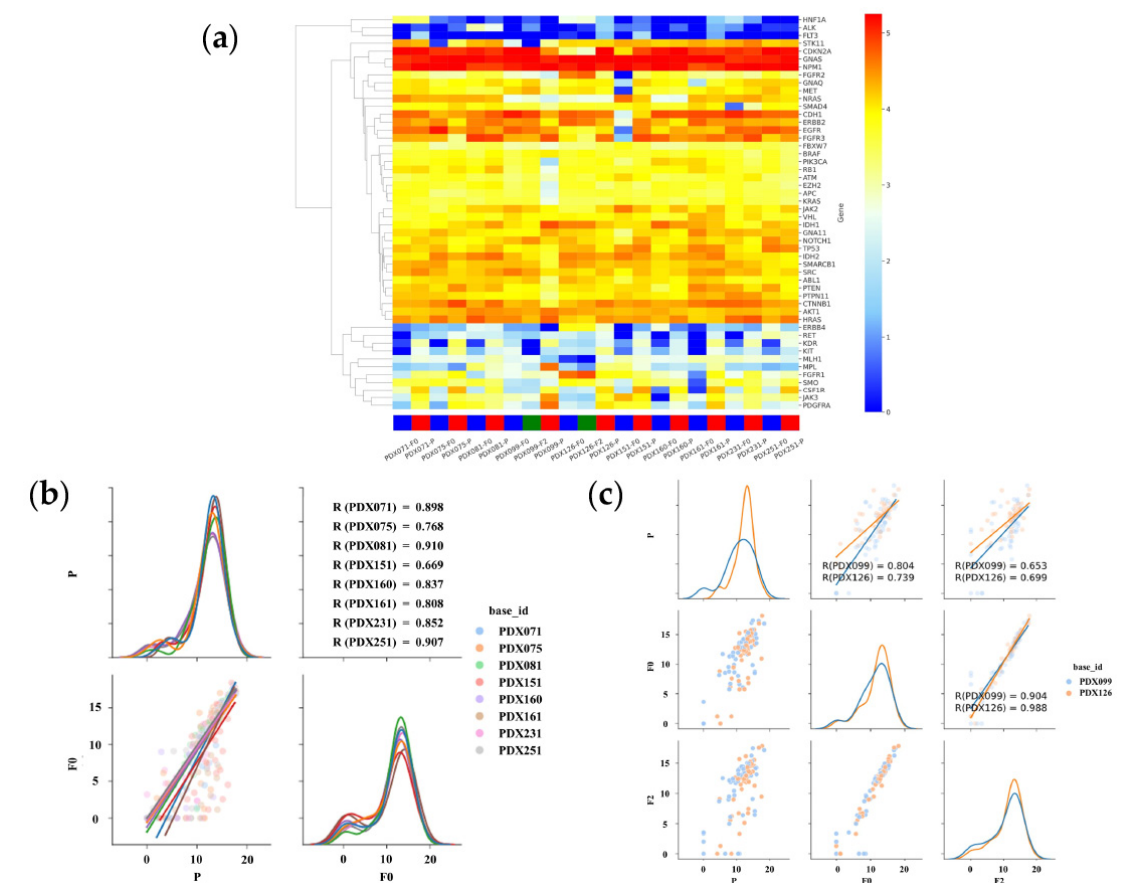
Figure 5. Summary of the relationship between gene expression in primary and PDX tumors based on RNA sequencing (RNA-seq). ( a ) The clustering and heatmap analysis of the mRNA profiling in tissues of the PDX and primary tumors using the AmpliSeq RNA Cancer Panel. In all cases, gene expression in primary (P) and PDX (F0 and F2) tumors are highly correlated. ( b ) Pair plot showing gene expression using the AmpliSeq RNA Cancer Panel in eight PDX (71, 75, 81,151, 160, 161, 231, and 251) models. The lower-left graph shows a scatter plot and linear regression of gene expressions in the P and F0 tumors. The diagonal graph shows the KDE. In all cases, gene expression in P and F0 tumors was found to be highly correlated. ( c ) Pair plot showing gene expression using the AmpliSeq RNA Cancer Panel in two PDX (99 and 126) models. The graph in the middle of the left column shows a scatter plot and linear regression of gene expression in the P and F0 tumors. The graph at the bottom of the center column shows a scatter plot and linear regression of gene expression in the F0 and F2 tumors. The lower-left graph shows a scatter plot and linear regression of gene expressions in the P and F2 tumors. The diagonal graph shows the KDE. In all cases, gene expression in P and F0 tumors was found to be highly correlated. Gene expression in F0 and F2 tumors is more highly correlated. Normalized data are converted to base 10 logarithms and z-scores.